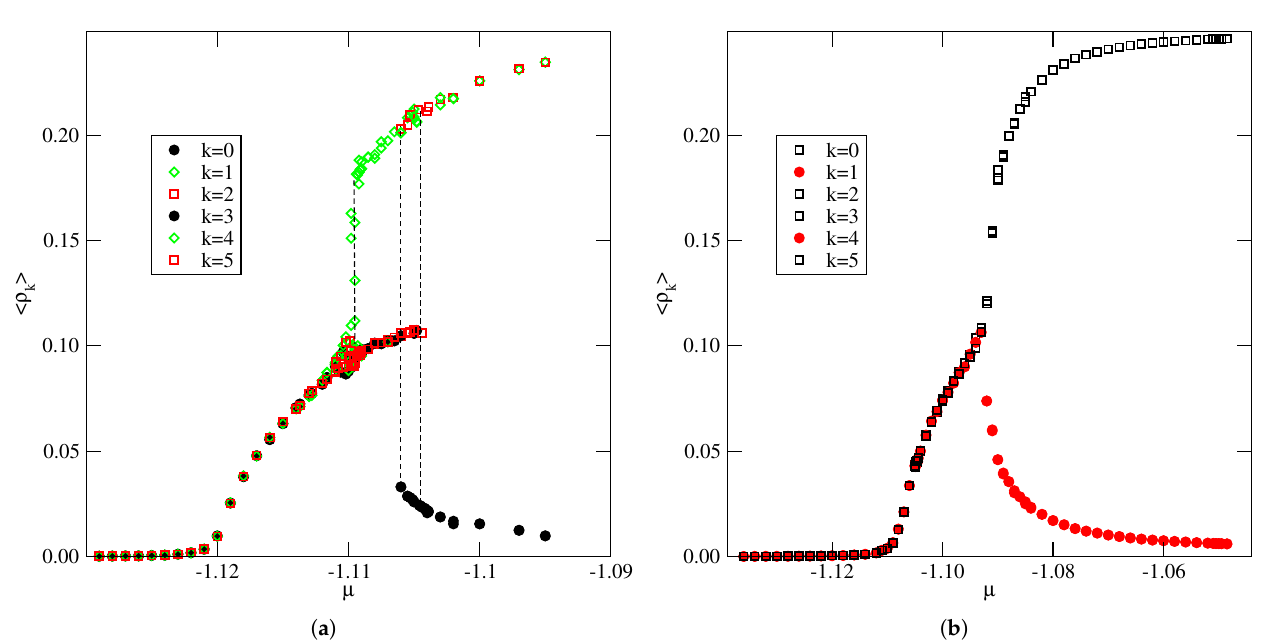
Figure 10. The changes of densities of differently oriented particles along the isotherm at T = 0.09 ( a ) and T = 0.10 ( b ), obtained for the system with u ∗ = − 0.01. The dashed vertical lines in part ( a ) mark the locations of density jumps due to the transitions. One should note the hysteresis loop accompanying the transition between Z 2 and Z phases.